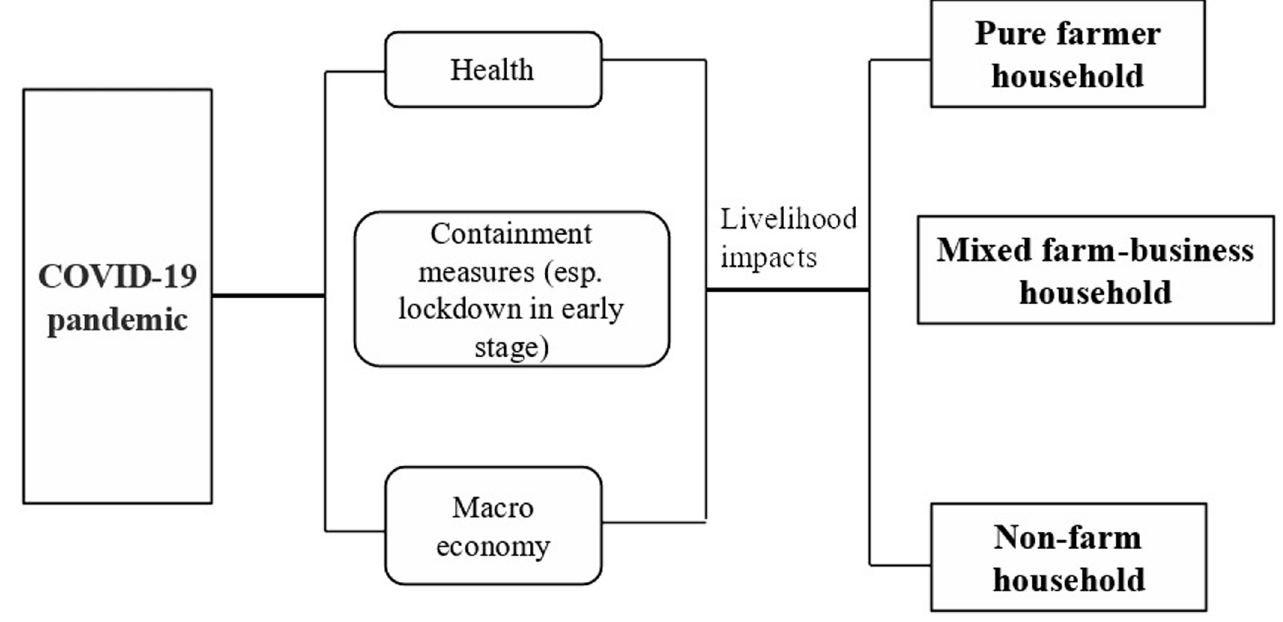
Fig 1. Mechanism of the livelihood impacts of COVID-19 pandemic on different rural households.